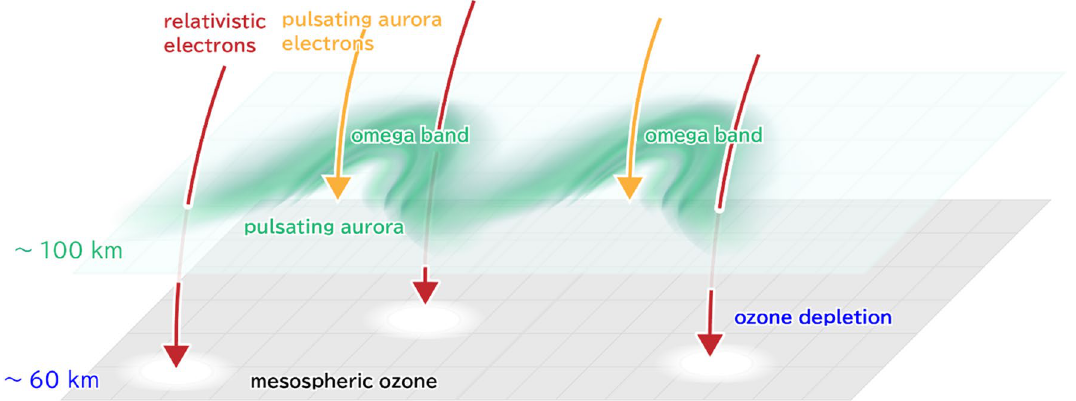
Figure 5. Schematic figure about simultaneous precipitations of tens keV electrons and relativistic electron precipitations. Schematic figure shows tens of keV electrons that cause pulsating aurora near the omega bands at the lower thermosphere. Simultaneously, sub-relativistic/relativistic electrons precipitate further into the mesospheric altitudes, causing significant ozone depletion. (Adobe Illustrator cc 2019. https:// www. adobe. com// produ cts/ illus trator.